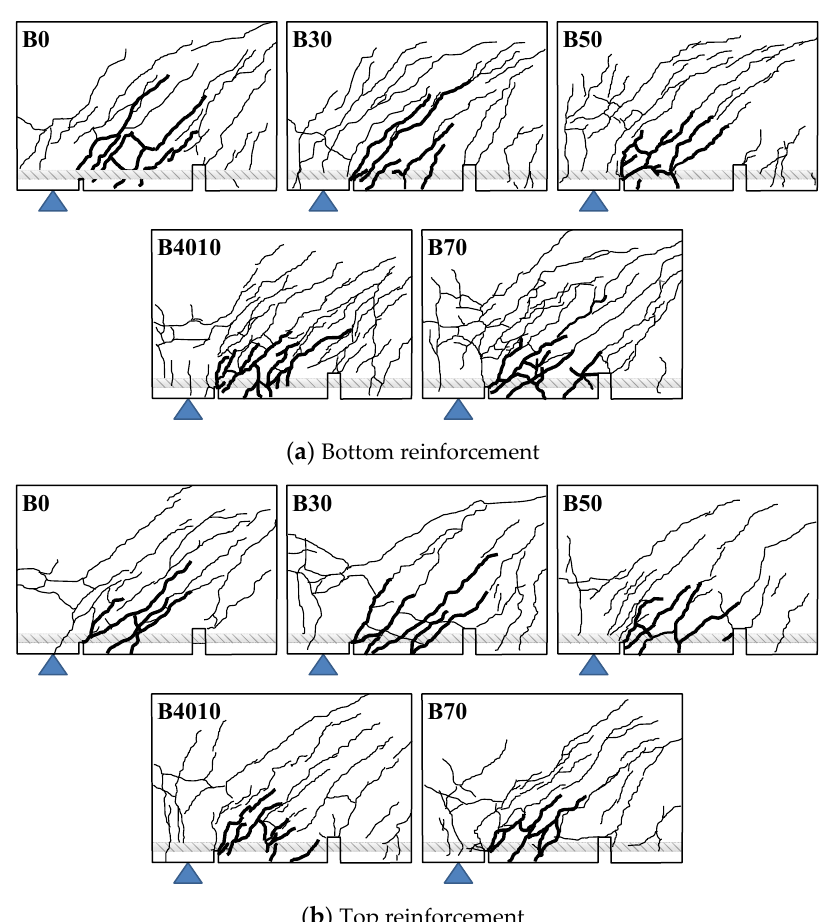
Figure 13. Crack patterns at failure of B series.